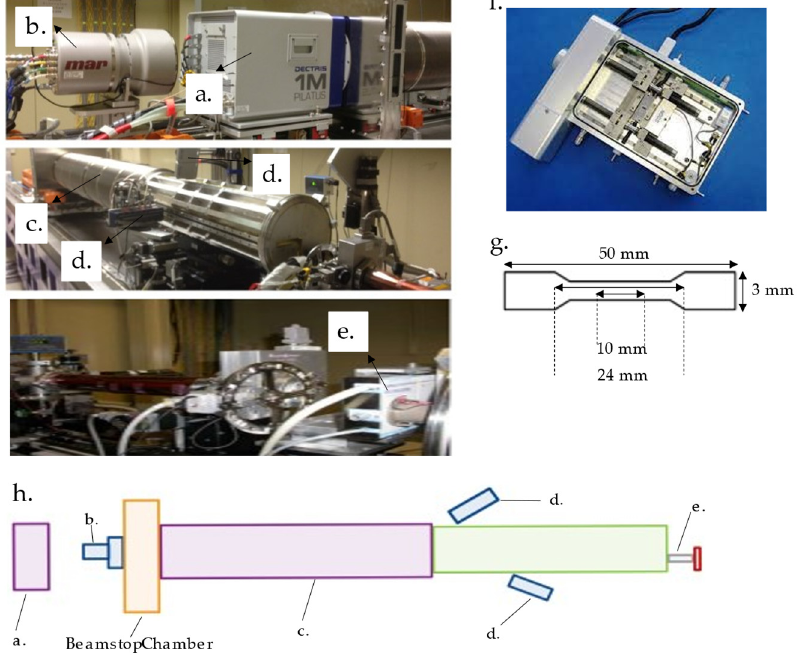
Figure 12. Experimental geometry for SAXS and WAXS. ( a ) Gas detector for SAXS; ( b ) Interchangeable CCD for SAXS; ( c ) Automatic bellow system for continuous changes in the sample-to-detector distance under vacuum; ( d ) Two linear detectors for WAXS; ( e ) Sample stage; ( f ) Tensile stress tester (Linkam TST350); ( g ) Schematic illustration of dumbbell-shaped tensile specimen; ( h ) The arrangement of a Small-/Wide-angle X-ray scattering instrument.